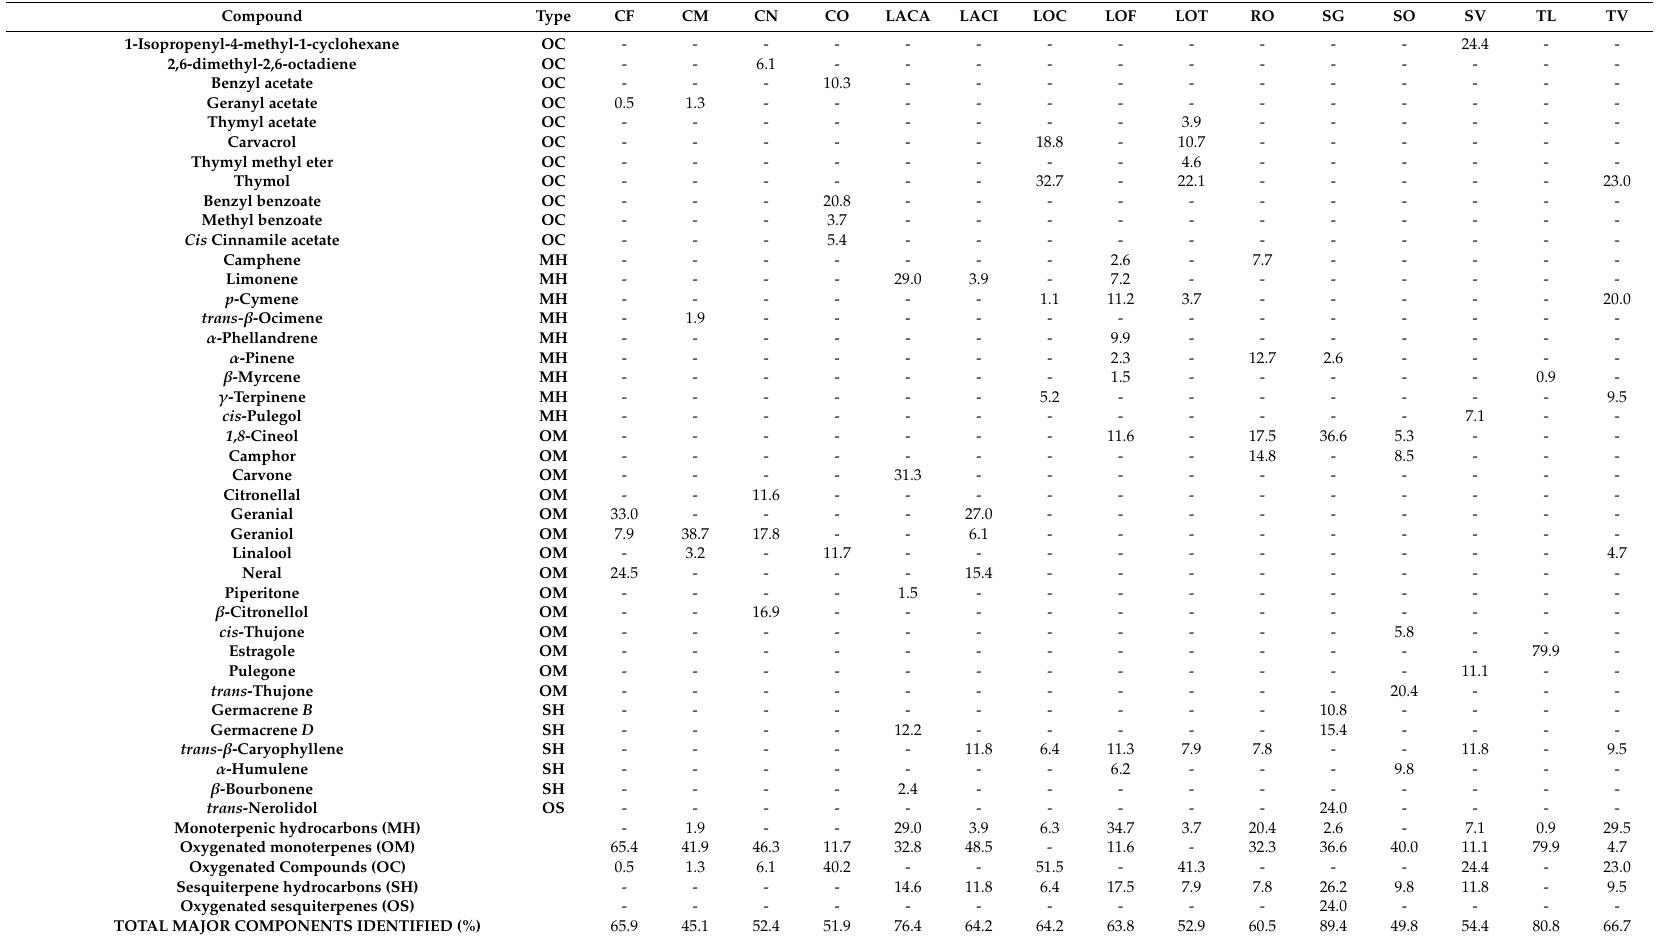
Table 1. Chemical composition of the major components (%) of essential oils: C. flexuosus (CF), C. martini (CM), C. nardus (CN), Cananga odorata (CO), L. alba, carvona chemotype (LACA), L. alba citral, chemotype (LACI), L. origanoides carvacrol, chemotype (LOC), L. origanoides phellandrene, chemotype (LOF), Lippia origanoides thymol chemotype (LOT), Rosmarinus o ffi cinalis (RO), Swinglea glutinosa (SG), Salvia o ffi cinalis (SO), Satureja viminea (SV), Tagetes lucida (TL), Thymus vulgaris